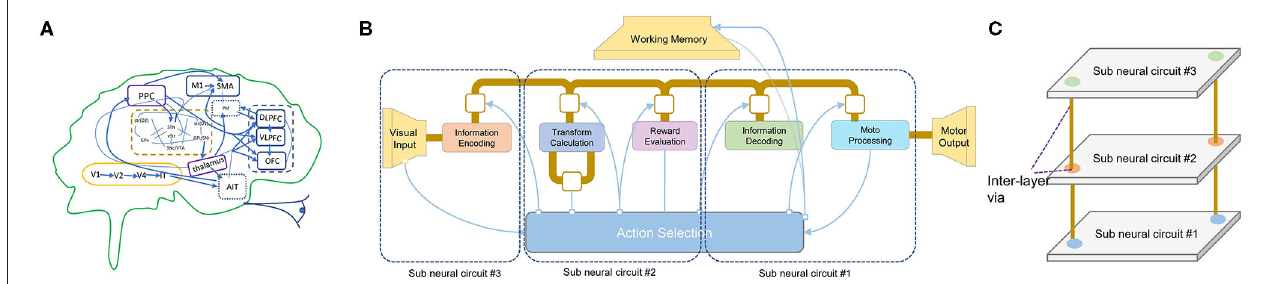
FIGURE 1 | Neuro-inspired 3D silicon brain. (A) The anatomical architecture of Spaun indicates major brain structures and their connectivity. (B) The architecture of Spaun, where thick dark-yellow lines illustrate communication between elements of the cortex while thin lines show connectivity between Basal Ganglia and the cortex. (C) A possible mapping of a Spaun system into 3D-IC.